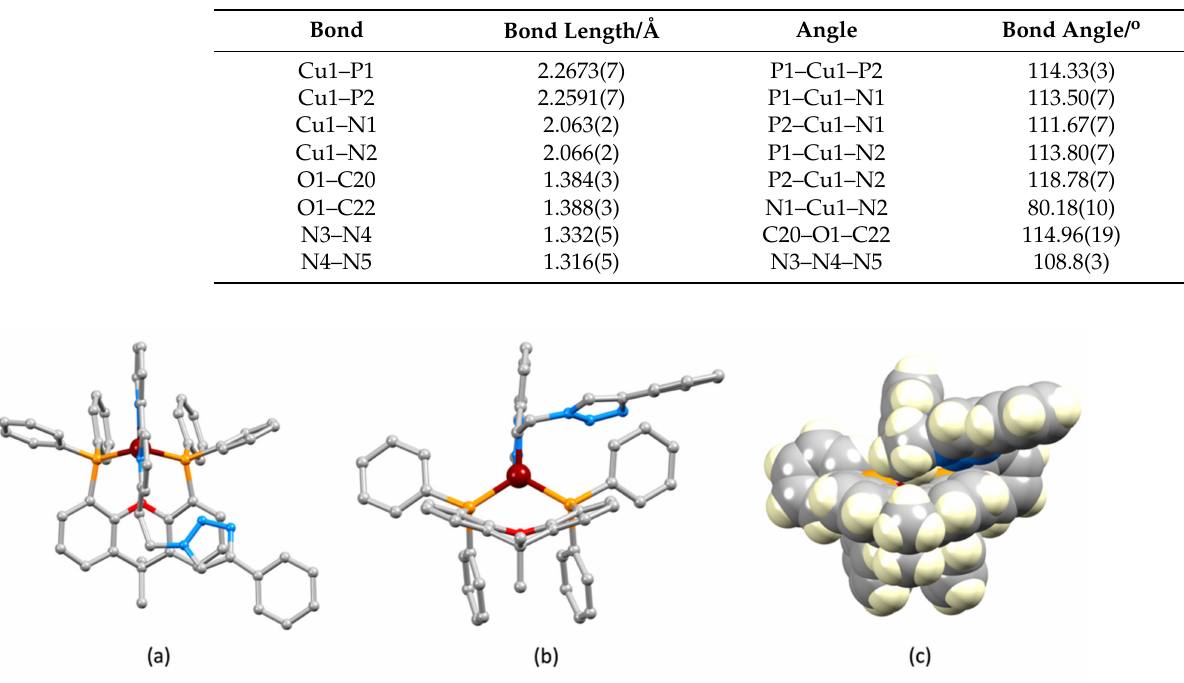
Table 1. Selected bond lengths and angles in the [Cu(xantphos)( 3 )] + cation. See Figure S5 (Supple- mentary Materials) for atom numbering.